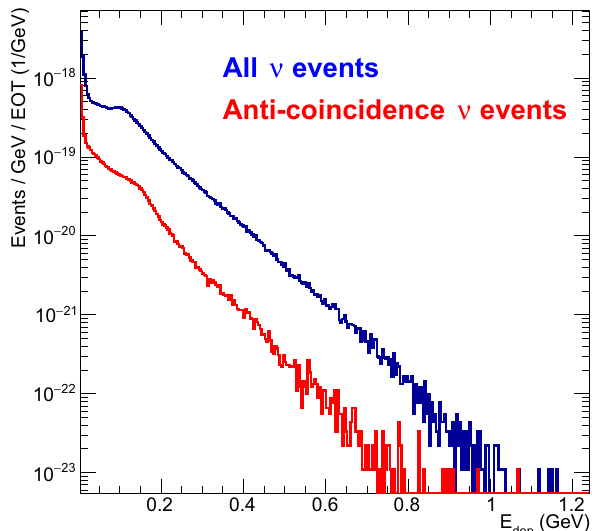
Fig. 11 Neutrino energy deposition spectrum in the BDX-MINI crys- tals,forallevents(blue)andforeventswithnosignalinthesurrounding veto (red)